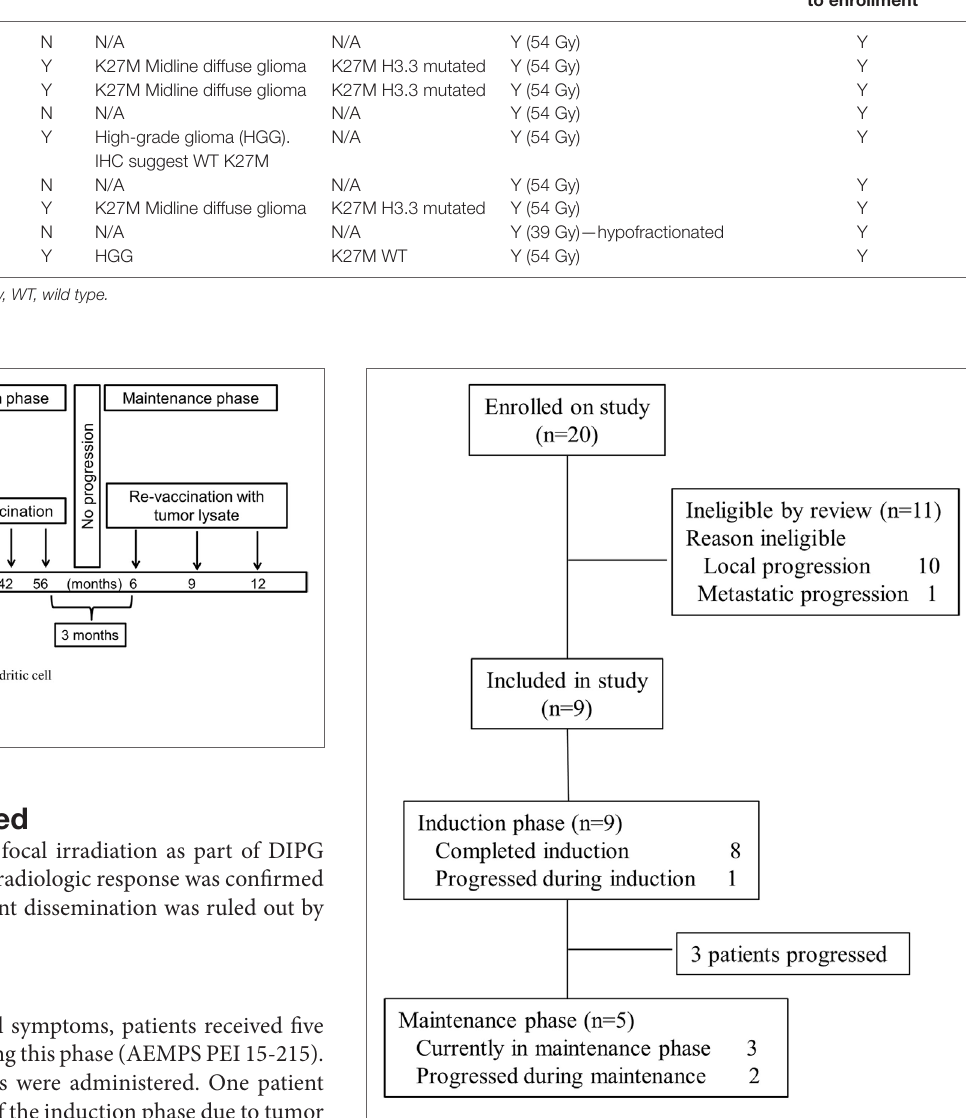
FiGUrE 2 | Consort diagram.